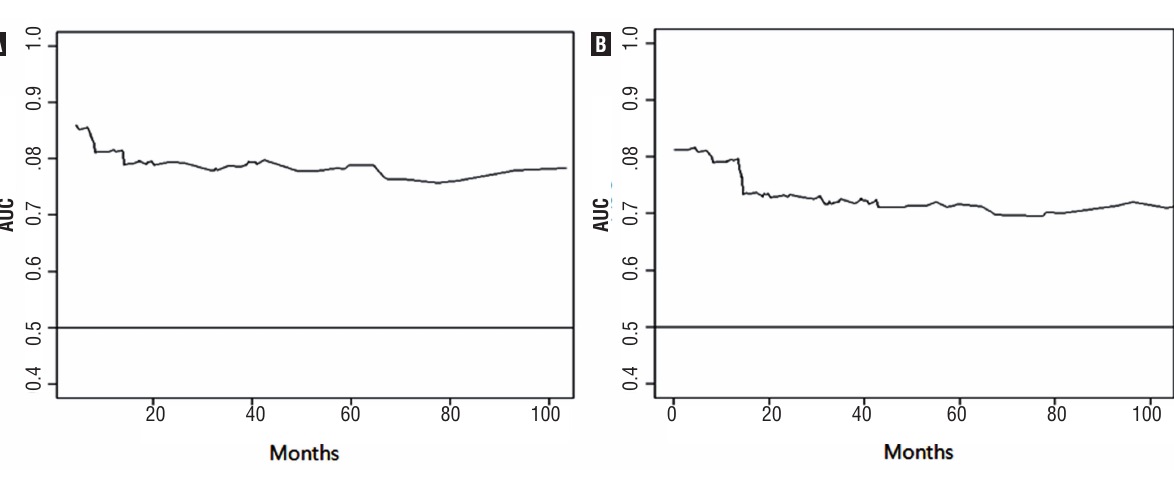
Figure 1 - Time-dependent receiver operating characteristics curve analysis of the Cox regression model. Curve plots the area under the curve over time. (A) Disease-specific survival. Integrated AUC value was 0.792. (B) Overall survival. Integrated AUC value was 0.739.